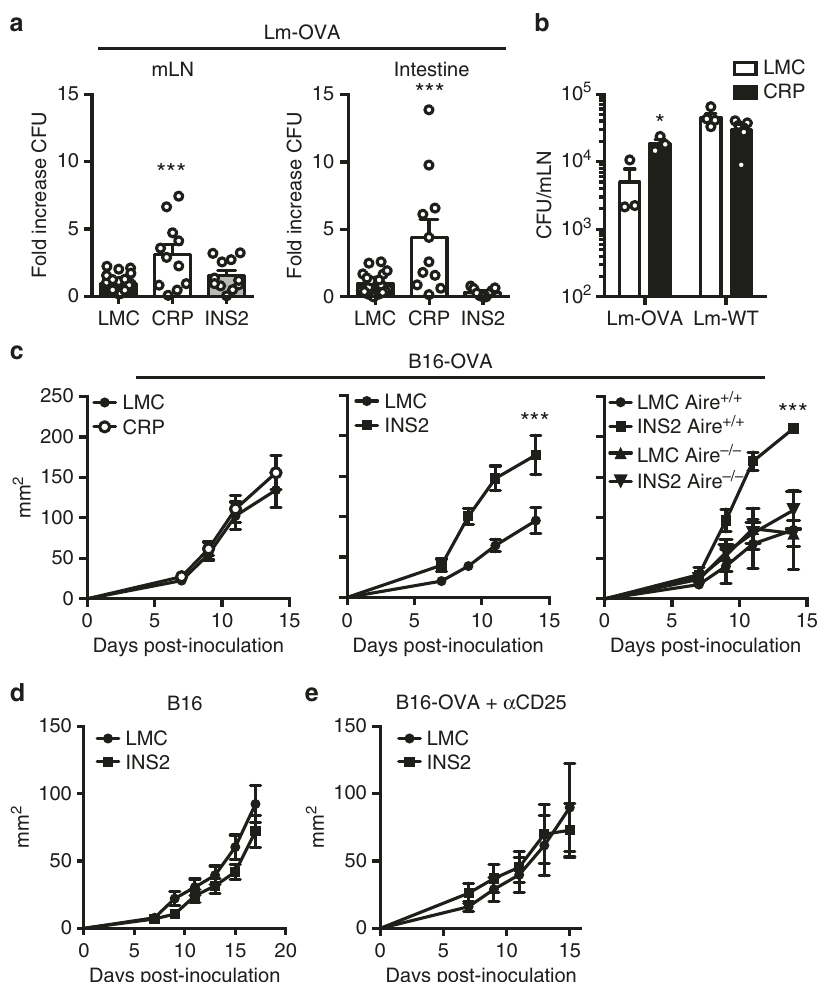
Fig. 7 Biased expression of TRA in distinct mTEC subsets differentially impacts control of bacterial infection and tumor growth. Low-density OT-I hematopoietic chimeras were infected by oral gavage with Listeria monocytogenes OVA (Lm-OVA) ( a, b ) or Lm-WT ( b ) and euthanized 3 days post- infection to determine the number of Lm bacteria in the mesenteric lymph nodes (mLN) and the small intestine. The results are reported as fold increase in colony forming units (CFU) as compared to littermate control (LMC) mice (mean± SEM, n = 20 LMC, 10 CRP, 10 INS2 mice) ( a ) and in CFU in the mLNs from the LMC and CRP Tg mice (mean ± SEM, Lm-OVA, n = 3 per group, Lm-WT, n = 4 per group) ( b ). B16-OVA c (mean ± SEM, n = 8 CRP LMC, 10 CRP Tg, 10 INS2 LMC, 10 INS2 Tg, 2 LMC Aire + / + , 3 Aire + / + INS2, 5 Aire − / − LMC, 4 Aire − / − INS2) or B16 d (mean ± SEM, n = 7 per group) cells were inoculated subcutaneously, and tumor growth was followed every 2 days by measuring tumor diameter and calculating the tumor area in the indicated mice. e INS2 Tg mice were injected with anti-CD25 depleting antibody 4 days and 1 day before B16-OVA cell inoculation, and tumor growth was measured every 2 days starting on day 7 post-inoculation (mean ± SEM, n = 10 per group). Data are pooled from two independent experiments. Statistical analyses were performed by Kruskal – Wallis test followed by Dunn ’ s post-hoc comparisons to LMC, two-sided a , a two-tailed Mann – Whitney U test b and